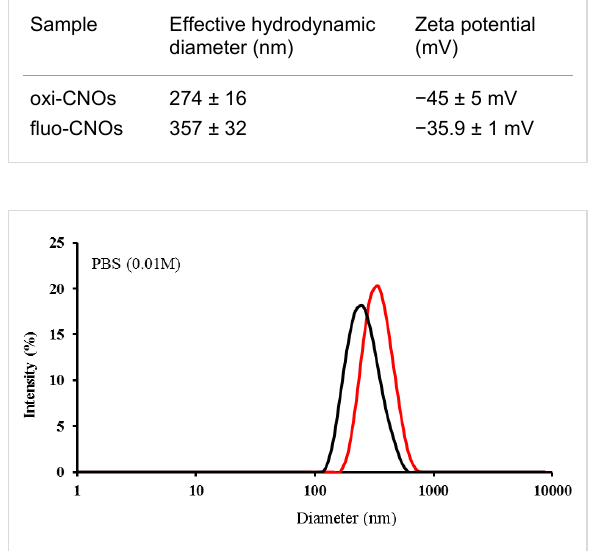
Figure 5: Effective hydrodynamic diameter of oxi-CNOs (black line) and fluo-CNOs (red line) in PBS at a concentration of 5 µg mL − 1 .